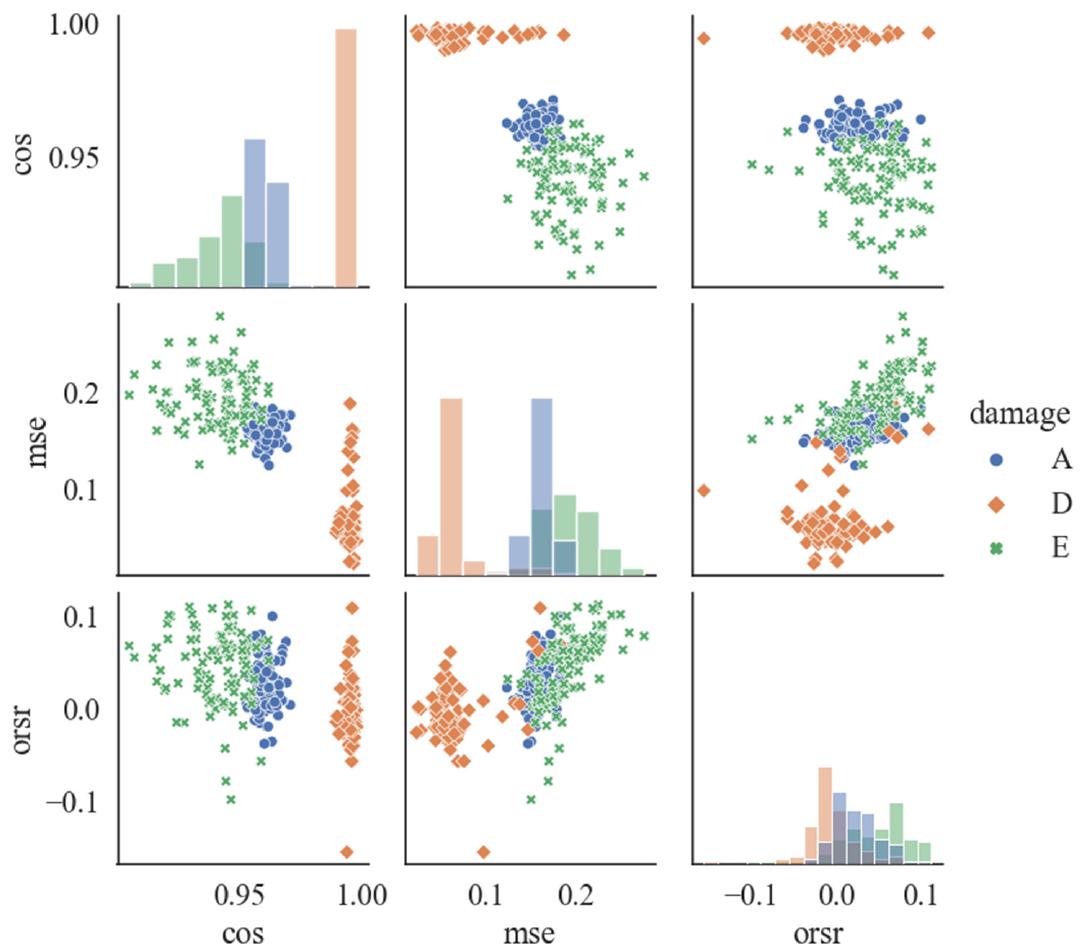
Figure 8. Distribution patterns for the AE-based features.